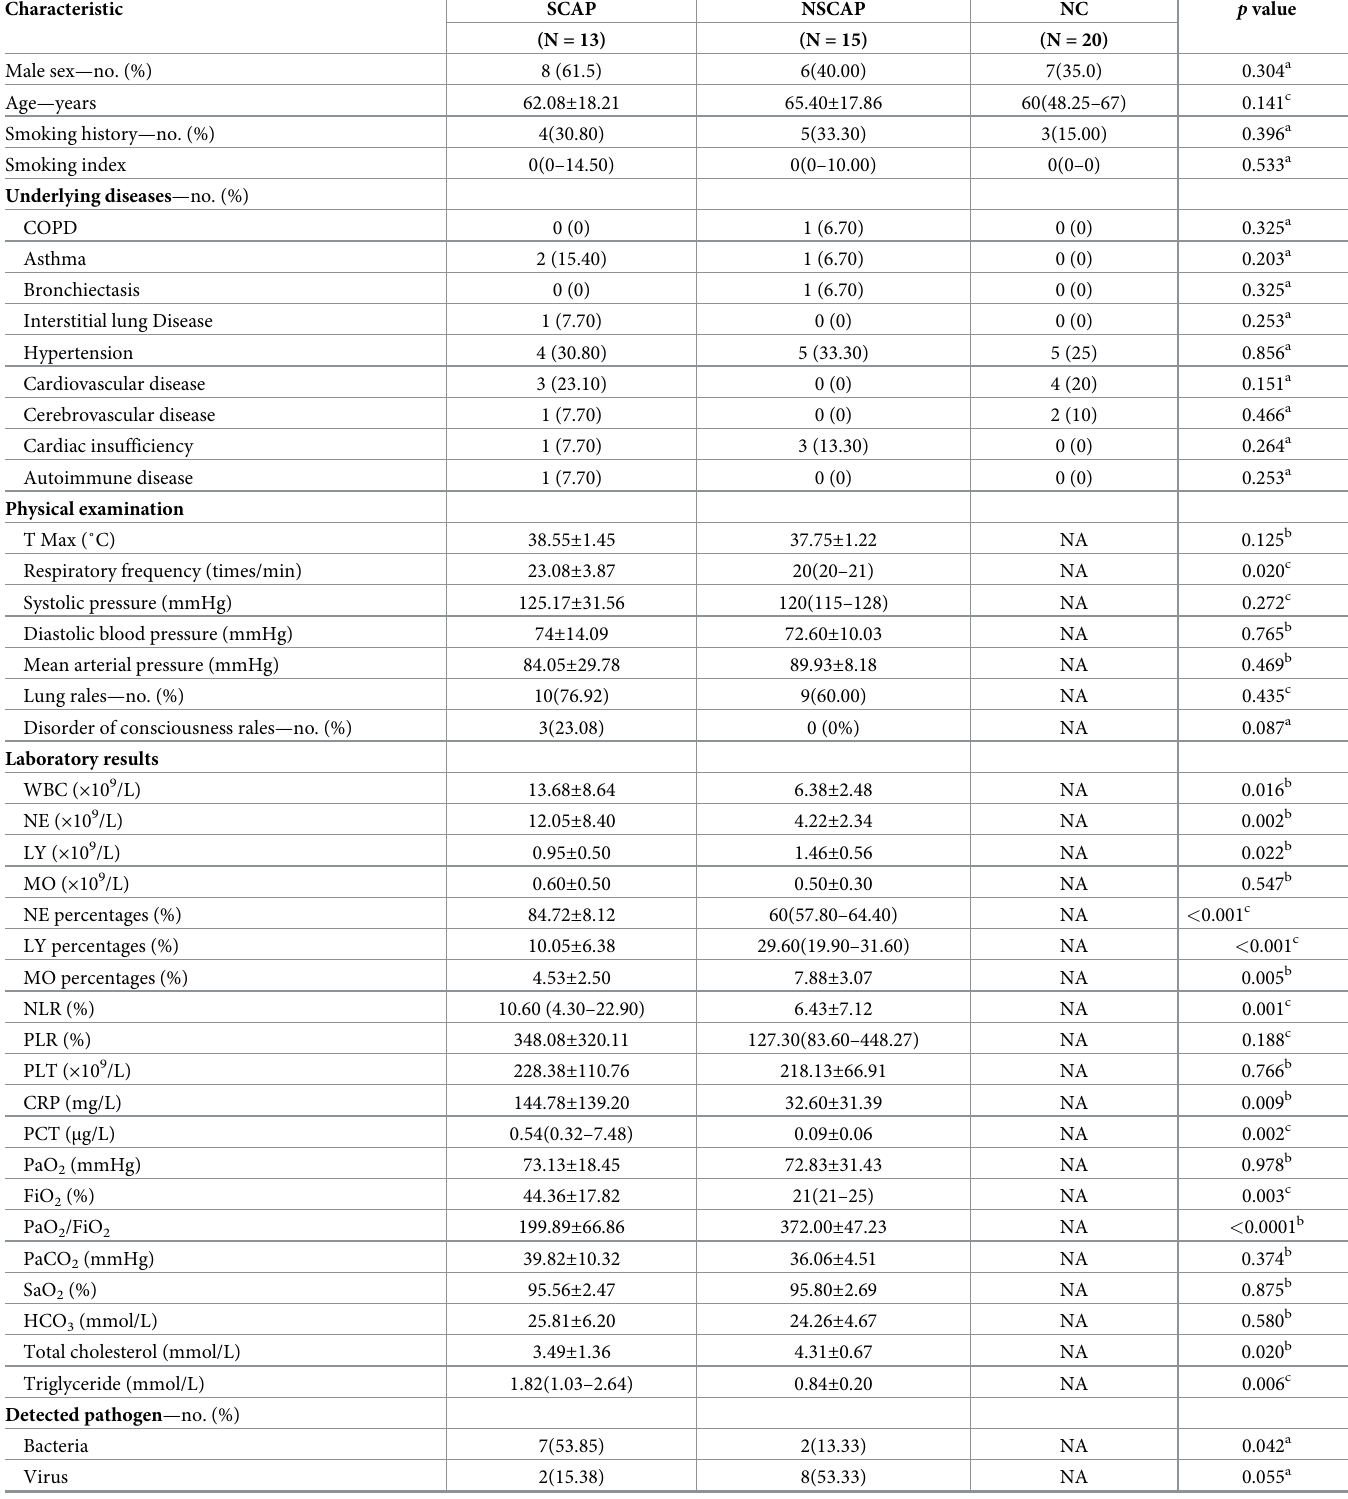
Table 1. Demographic and clinical characteristics of 48 study